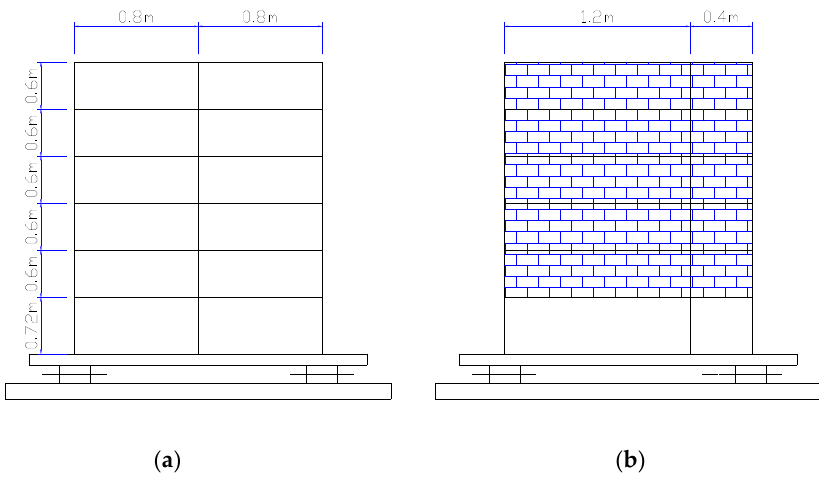
Figure 3. Structure’s model dimension. ( a ) Secondary shock direction; ( b ) The main shock direction.